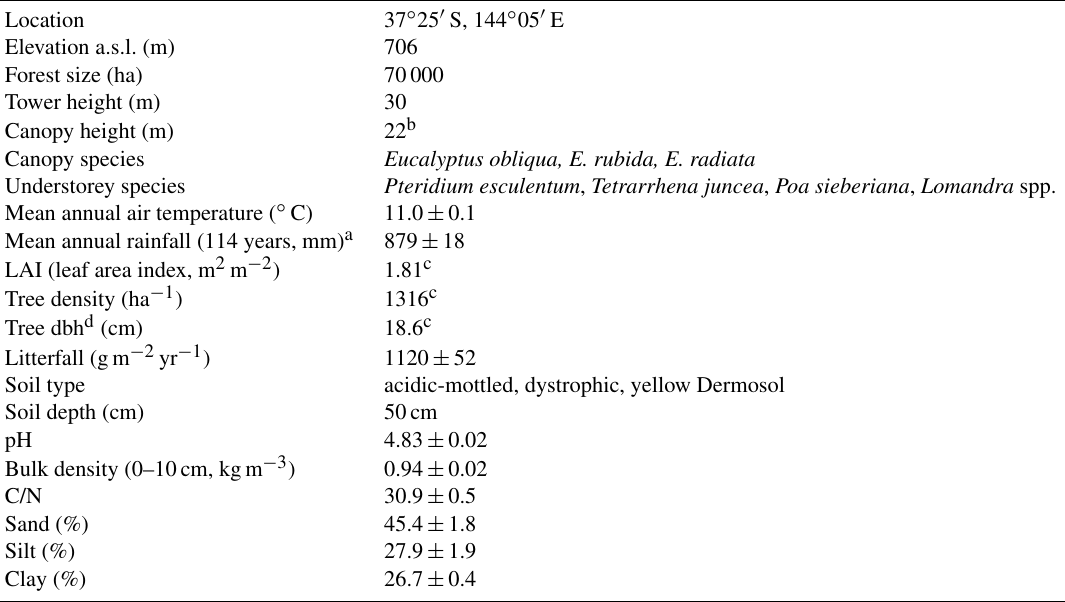
Figure 1. Climate time series of (a) monthly averages of minimum (grey lines) and maximum (black lines) air temperatures from the study site from 2010 to 2012 (solid lines) and from the BoM station Ballarat from 2001 to 2013 (dashed lines); shaded areas indicate ± 1SE. (b) Monthly rainfall at the Wombat State Forest OzFlux EC tower site from 2010 to 2012 (grey bars) and 114-year (1901–2014) long-term monthly mean rainfall at the BoM station Daylesford (black line). Table 1. Site and tower characteristics for the Wombat State Forest OzFlux